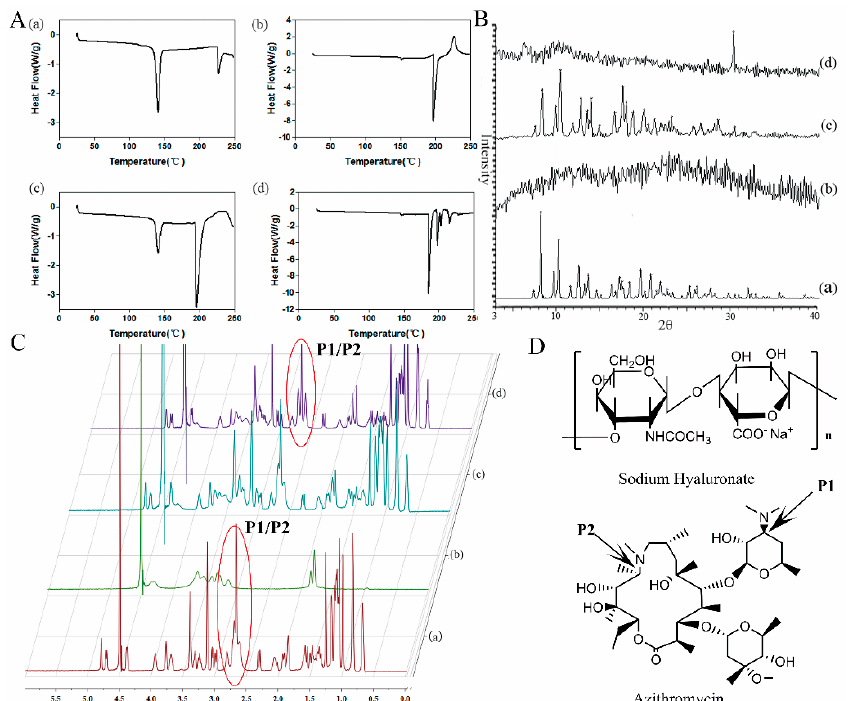
Figure 2. Illustration of interaction between AZI and sodium hyaluronate (SH). A : Differential Scanning Calorimetry (DSC) thermograms; B : X-ray diffraction (XRD) patterns; C : 1 H-Nuclear Magnetic Resonance ( 1 H-NMR) spectra. (a) AZI, (b) SH, (c) physical mixture of AZI+SH and (d) AZI-SH complex. D : structure of sodium hyaluronate and azithromycin.